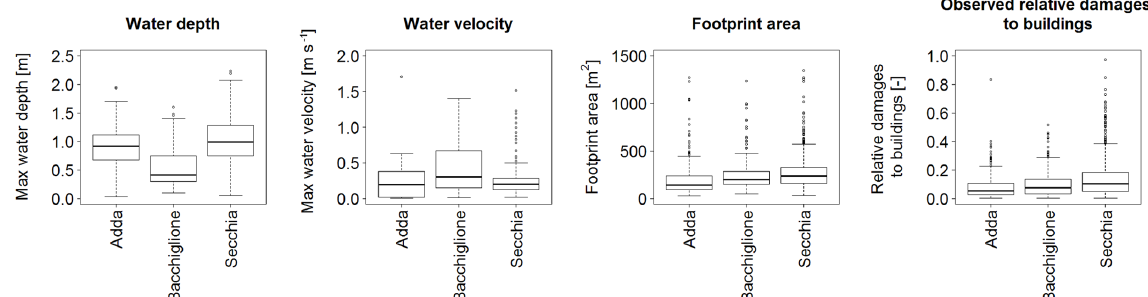
Figure 6. Data distribution for four variables from the three sample case studies.